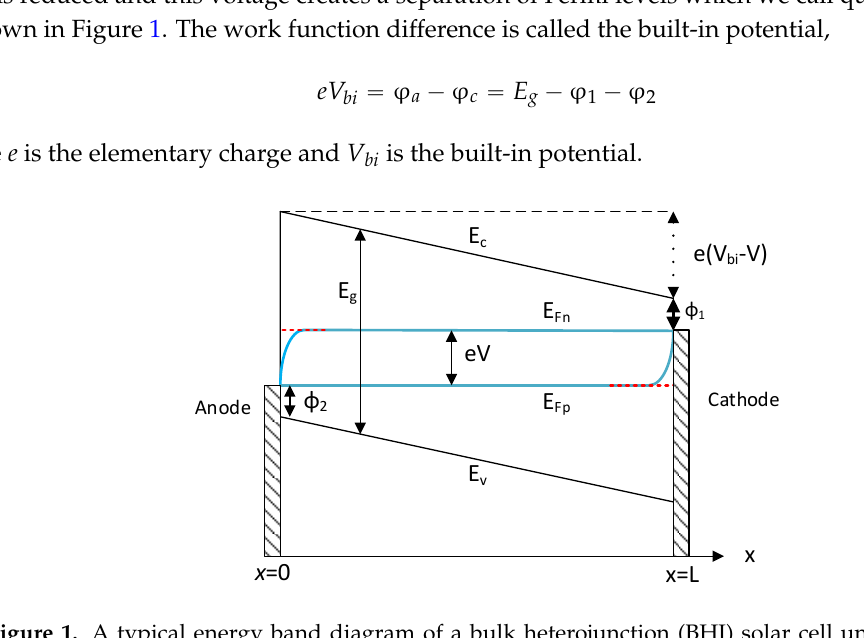
Figure 1. A typical energy band diagram of a bulk heterojunction (BHJ) solar cell under applied bias ( V ). Here x is the distance from the anode (radiation-receiving electrode).